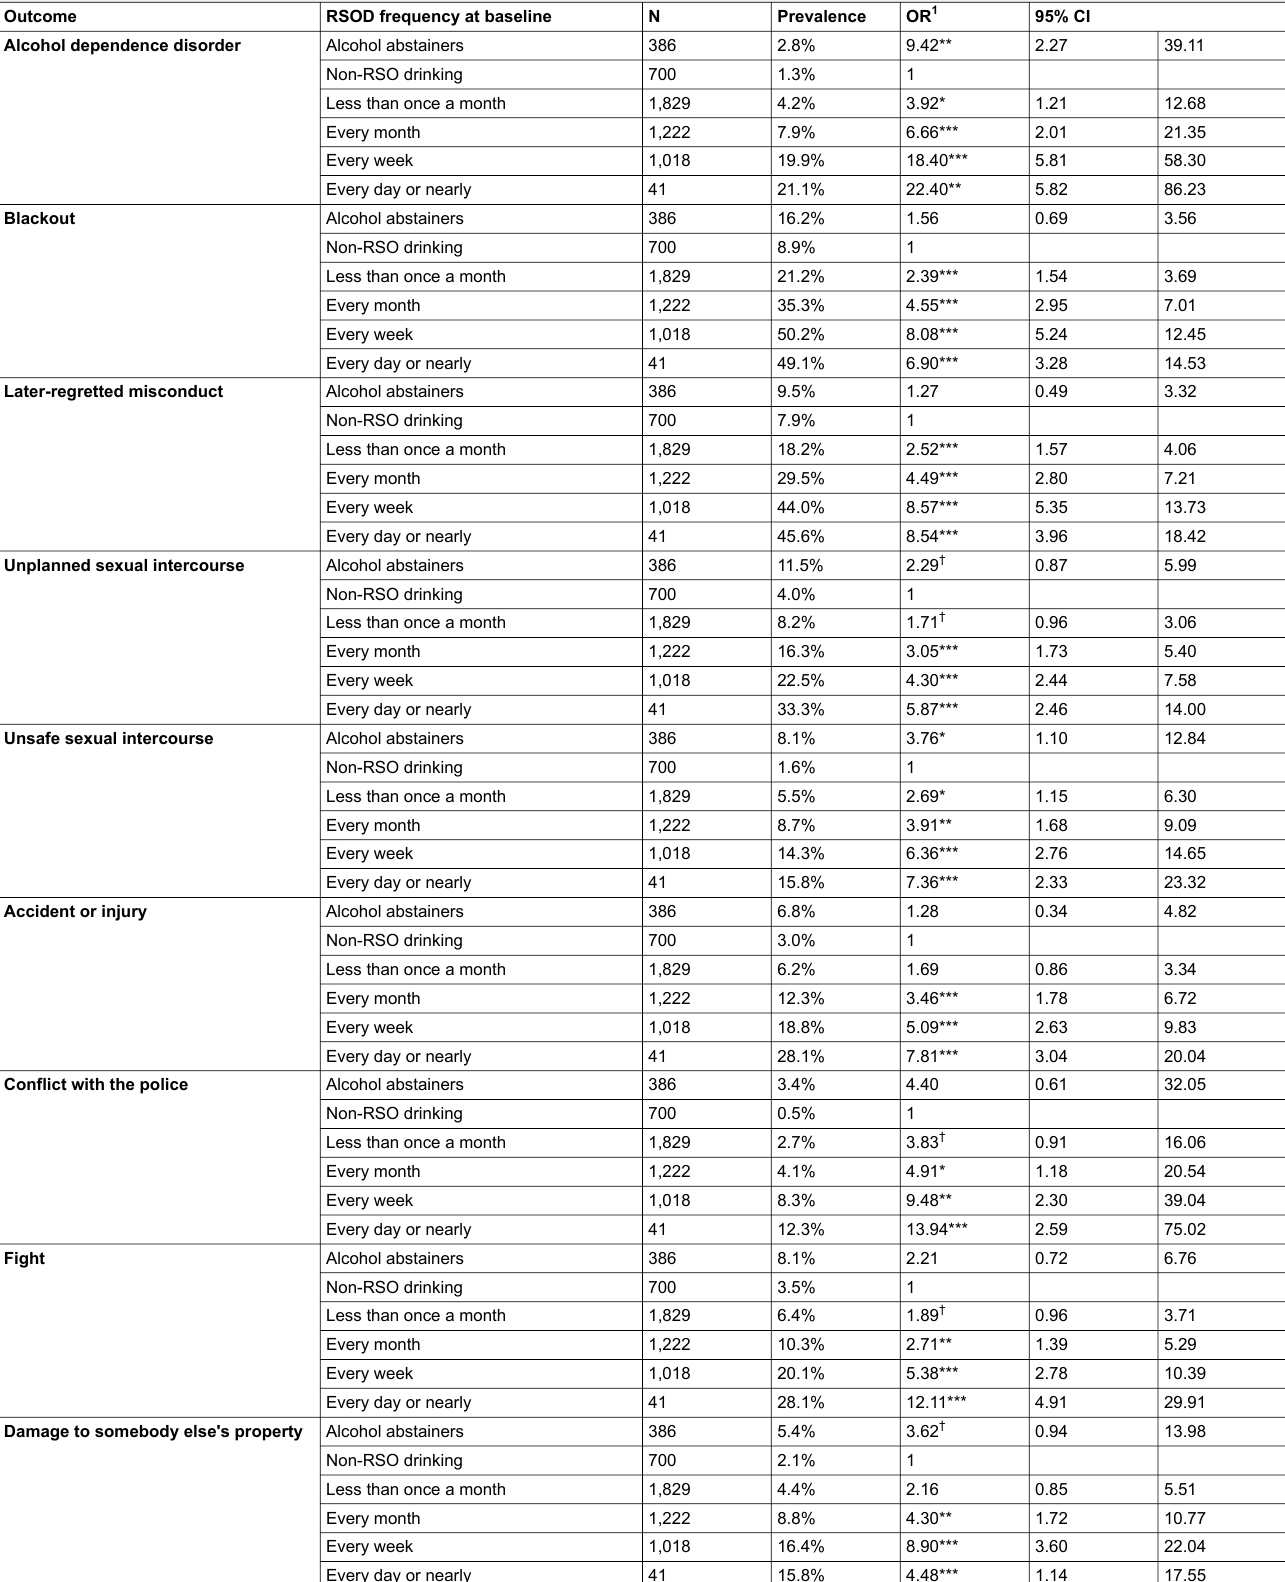
Table 3: Associations of RSOD frequency with alcohol dependence and drinking consequences.